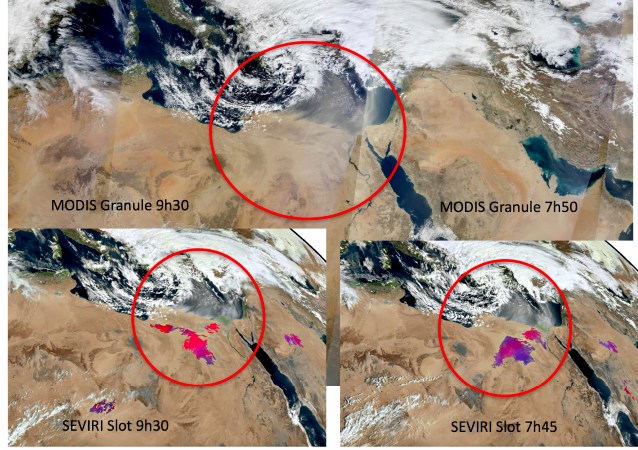
Figure 6. MODIS (Plate Carre projection) ( top ) versus SEVIRI (No projection) ( bottom ) (19 February 2011).